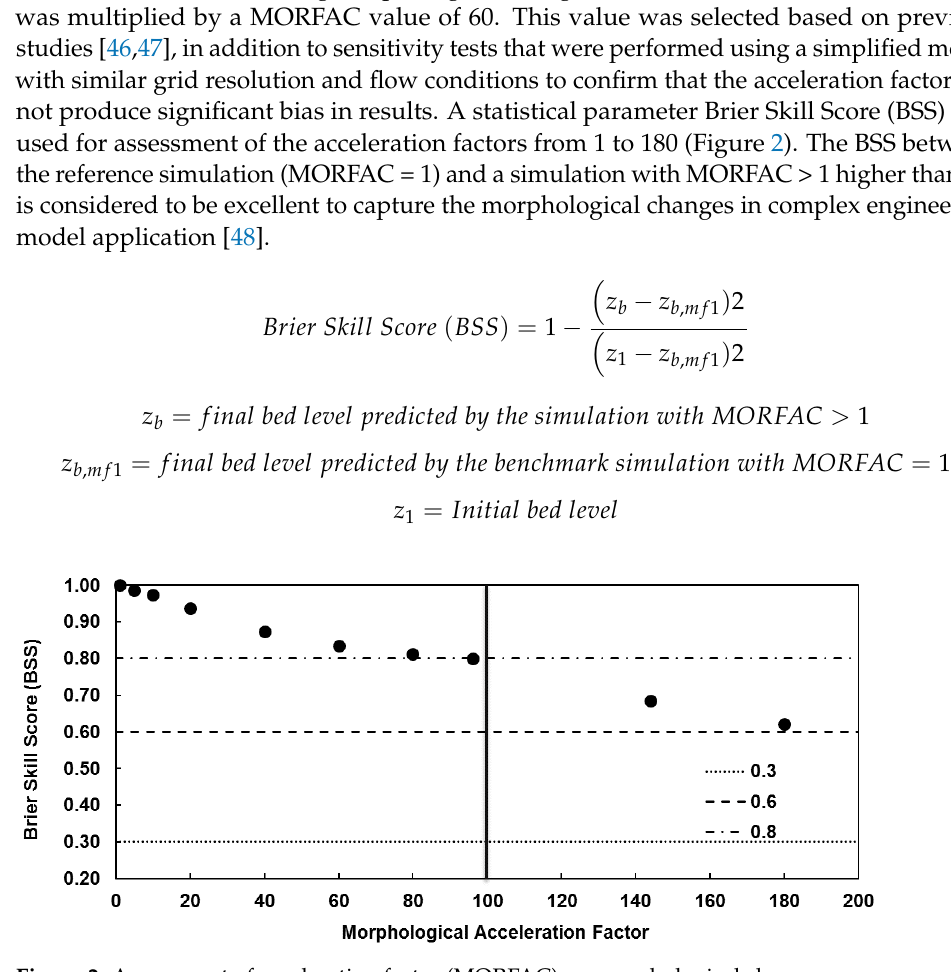
Figure 3. Calibration results showing comparison of modeled and observed velocities at Greg Pass.